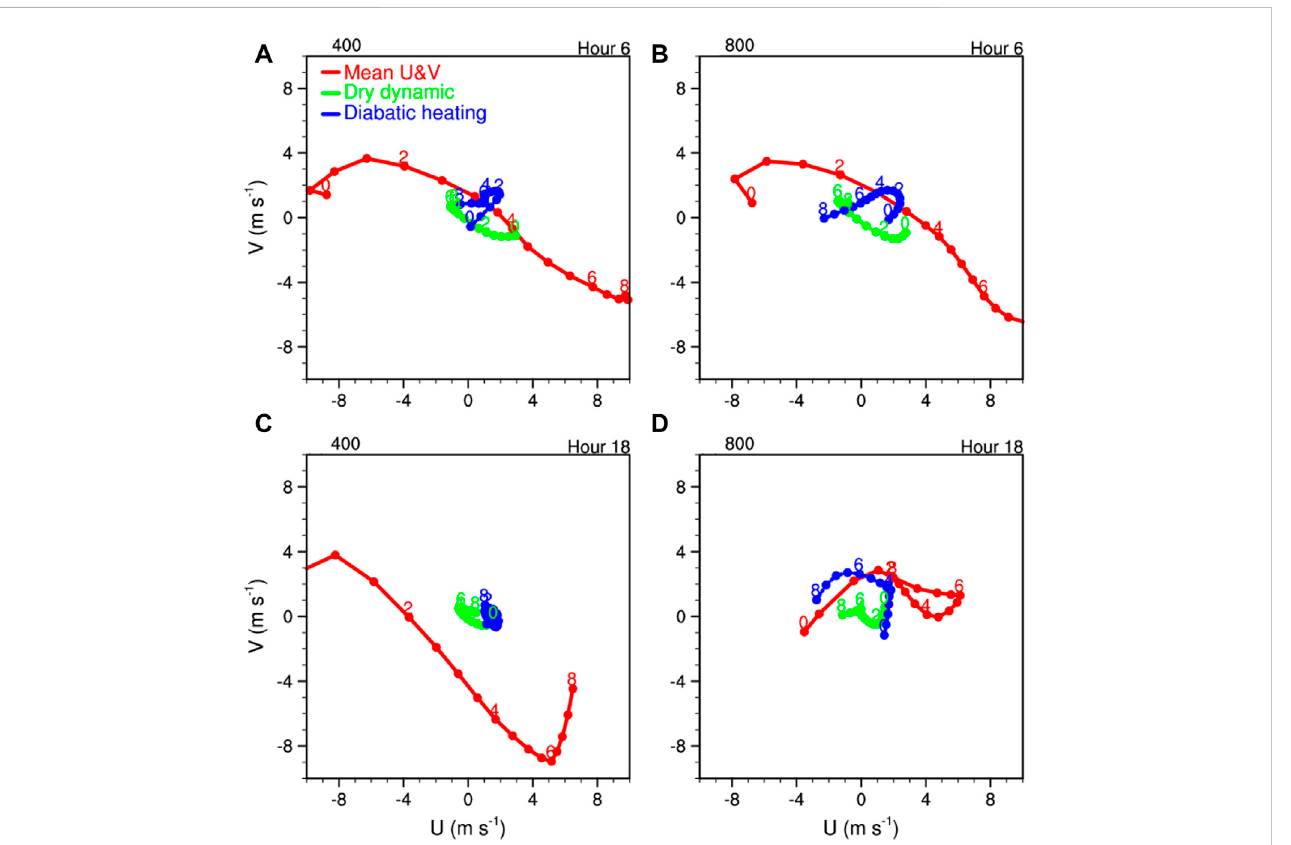
FIGURE 13 Hodographsofthedivergence windforcedbydry dynamic heating(green),diabaticheating(blue), andthemeanhorizontalwind(red)averagedwithina 50-km radius centered in the eye. Each dot indicates a 0.5 km height increment, beginning at the surface and ending at 8 km. (A,C) Data from EXP400. (B,D) Data from EXP800. (A,B) are at hour 6, and (C,D) are at hour